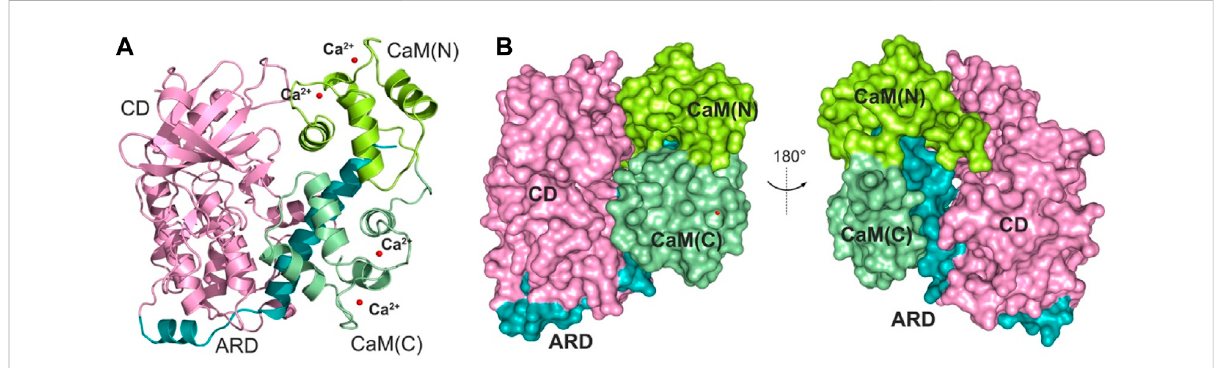
FIGURE 1 (A) Cartoon representation of the crystal structure of the DAPK1 − CaM complex (PDB ID: 2X0G). The catalytic domain (CD) and the autoregulatory domain (ARD) of the DAPK1 are colored by pink and teal, respectively. The N- and C-terminal CaM are colored by limon and palegreen, respectively. Ca 2+ ions are shown by red spheres. (B) Surface representation of the DAPK1 − CaM structural complex.